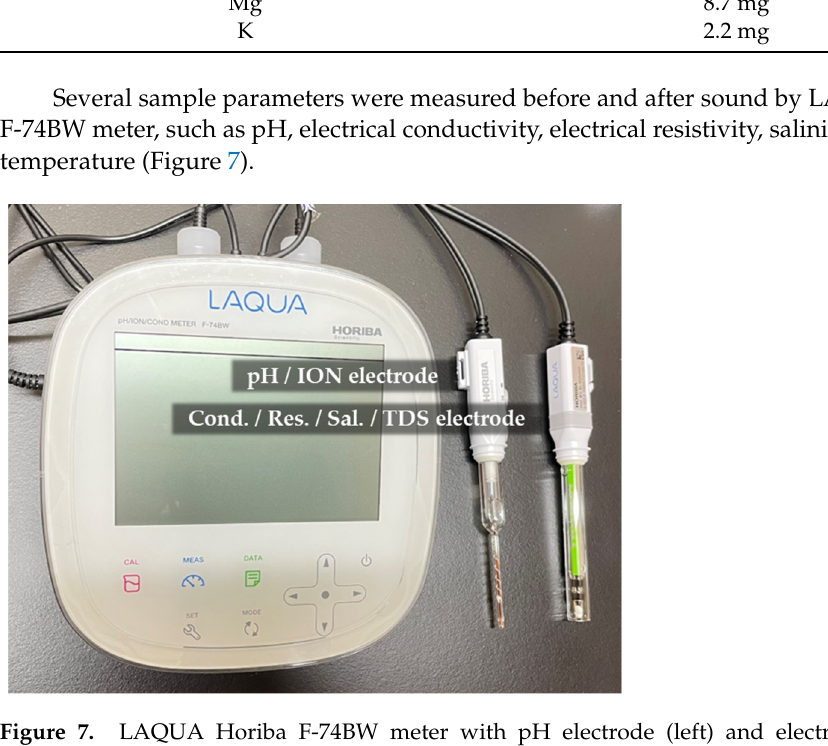
Table 4. Mineral content for Yunosato Gold mineral water (MW) as described on the bottle’s label. Nutritional Information Per 1000 mL Calories from proteins, fats, carbohydrates